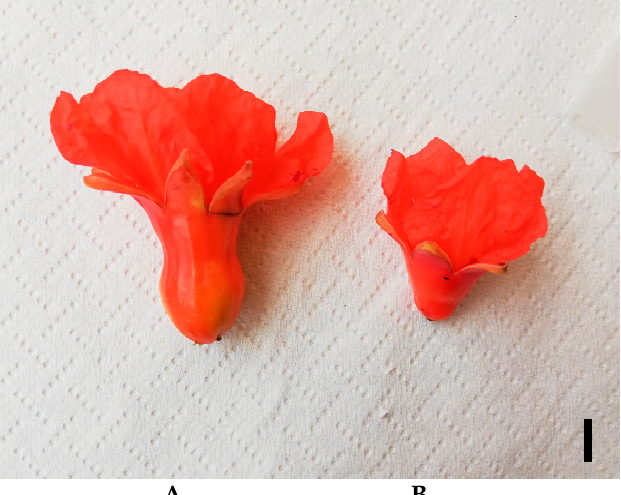
Figure 7. A hermaphrodite vase-shaped flower ( A ) and a male bell-shaped one ( B ) in ‘Comune S. Ggiorgio’. The bar represents 1 cm.